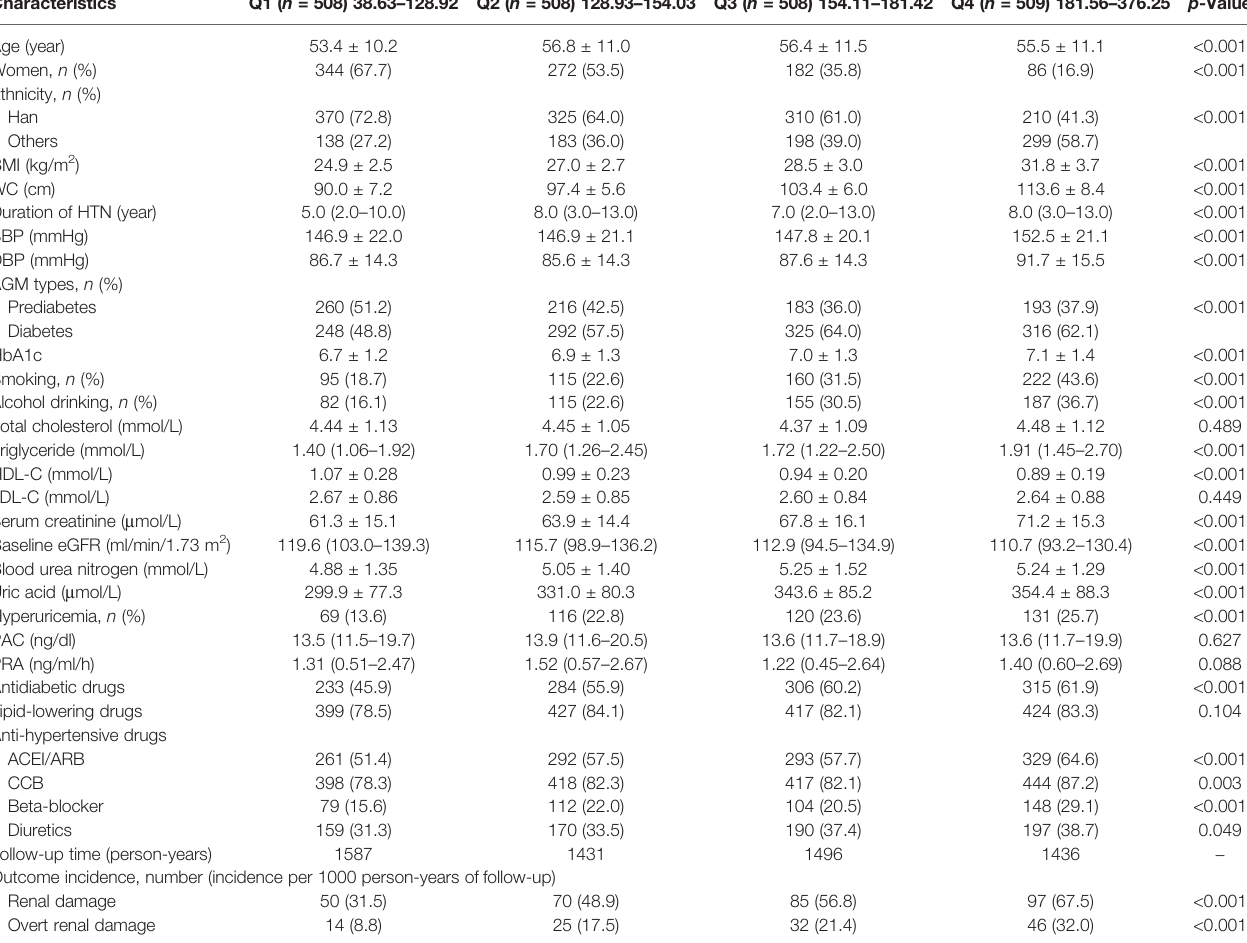
TABLE 1 | Baseline characteristics of study population across CVAI quartiles.